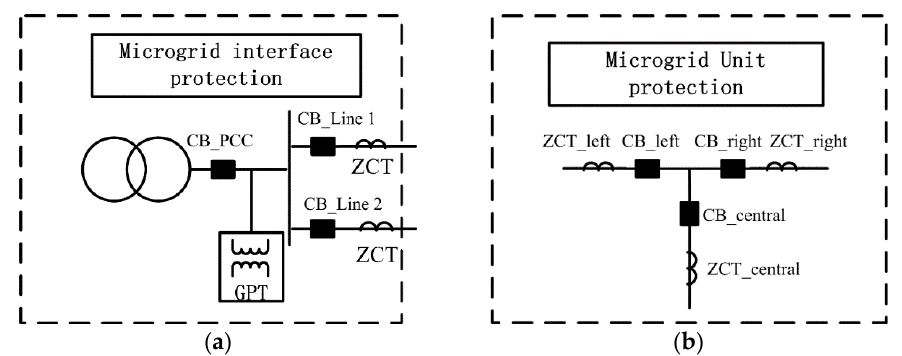
Figure 5. Microgrid interface protection and unit protection: ( a ) interface protection; ( b ) unit protection. CB, circuit breaker.